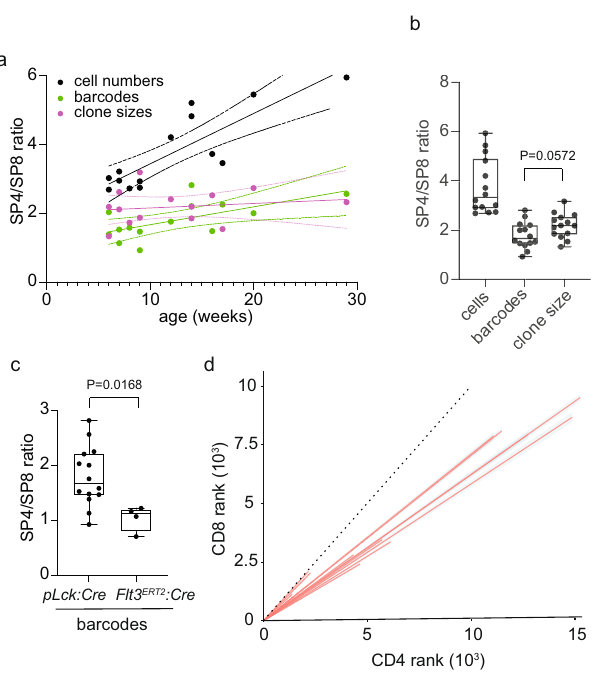
Fig. 3 Structure of thymocyte populations. a Age-dependent trends of cell and barcode numbers and clone sizes expressed as SP4/SP8 ratio to normalize for inter-individual differences in barcoding ef fi ciency as a function of age. Solid line, linear regression; dashed lines, 95% con fi dence interval. b Aggregated values of parameters shown in a. Box plots show quantiles 25 and 75 and mean (line) as well as the total range (whiskers); t- test, two-tailed ( n = 14; P value is indicated). c Barcodes recovered from thymocyte populations barcoded at the DN2/DN3 stage of intrathmyic differentiation ( pLck:Cre ; n = 12) and at the LSK stage of lymphoid differentiation in the bone marrow ( Flt3 : Cre ERT2 ; n = 4). The difference between the populations is signi fi cant (t-test, two-tailed; P value is indicated). Box plots show quantiles 25 and 75 and mean (line) as well as the total range (whiskers). d Rank-rank correlation of shared barcodes in SP4 and SP8 thymocytes. The dotted line indicates a 1:1